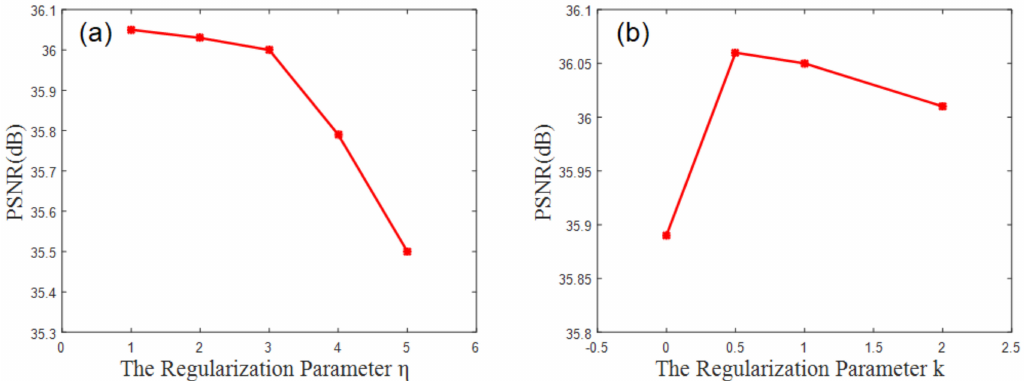
Figure 10. ( a ) The effect of the regularization parameter η on the results; ( b ) the effect of the regularization parameter k on the